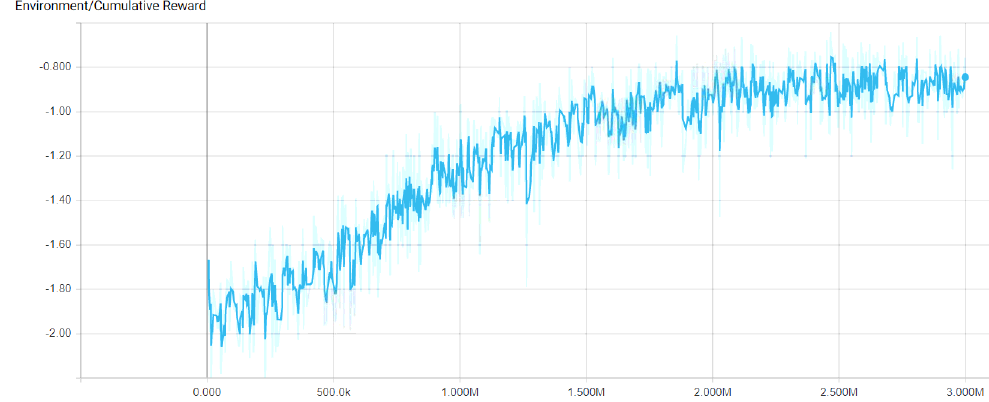
Figure 8. Cumulative reward statistics.